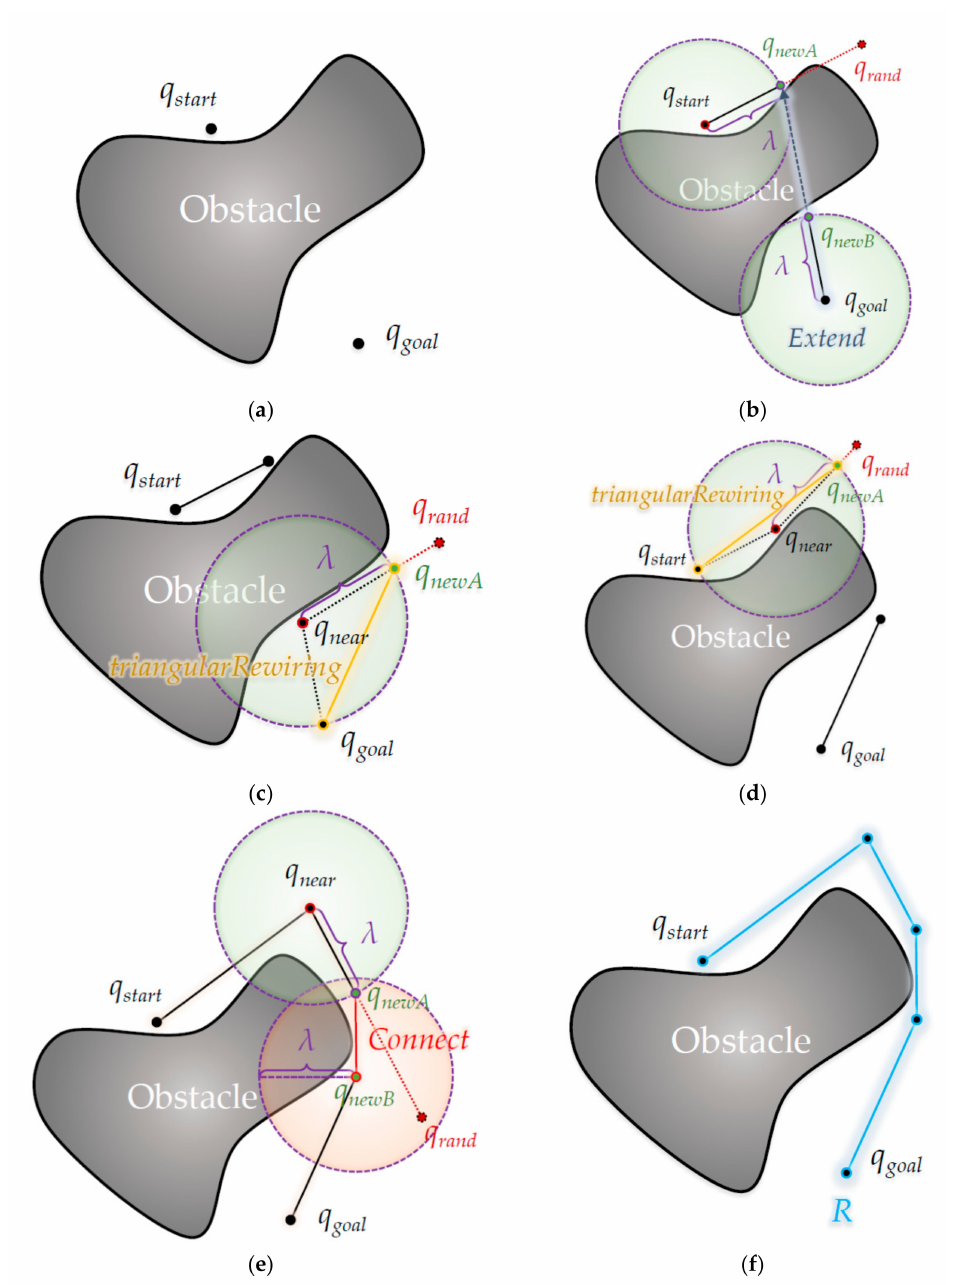
Figure 9. Detailed process of the proposed algorithm: ( a ) Start position q start from tree T a and goal position q goal from tree T b ; ( b ) Create q newA nearest to T a from 1 st random sampling position q rand and create q newB from q goal nearest to T b ; ( c ) Create new q newA from q near nearest to T b from the second random sampling position q rand and rewire between q newA and q goal the ancestor of the q newA ; ( d ) Create a new q newA from q near nearest to T a from the third random sampling position q rand and rewire between q newA and q start with the ancestor of q newA ; ( e ) Create new q newA from q near nearest to T a from the fifth random sampling position q rand and connect between q newA and q newB nearest to T b from q newA ; ( f ) Result of Path R from q start to q goal